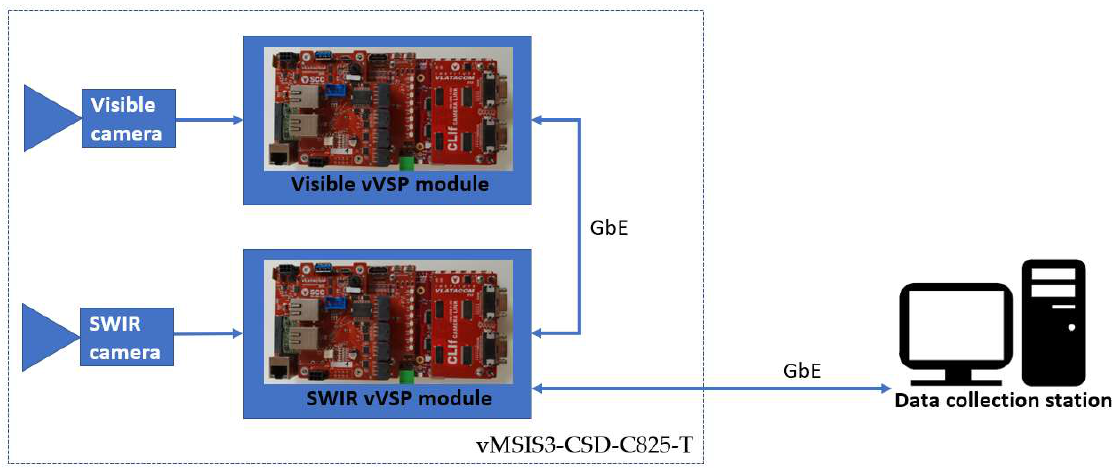
Figure 4. Block diagram of the connecting cameras to data collection